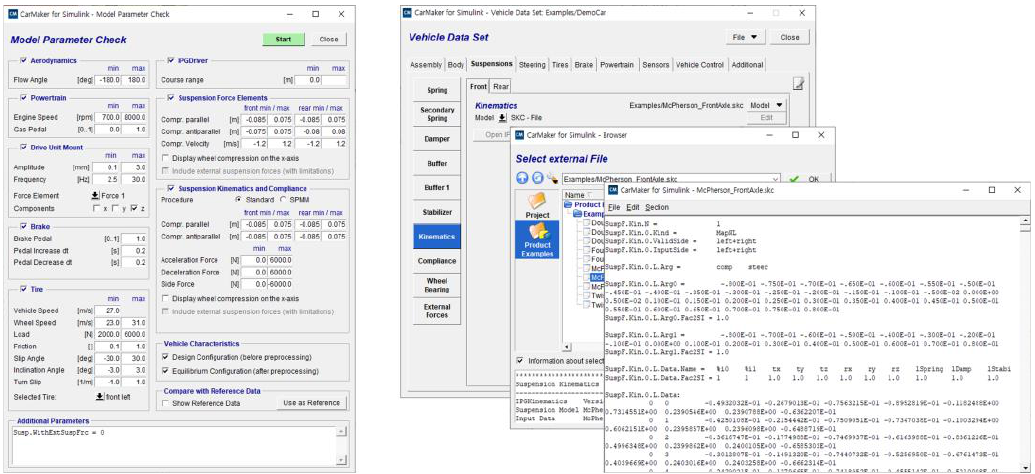
Figure 5. IPG CarMaker Software Vehicle Model Parameter setting.